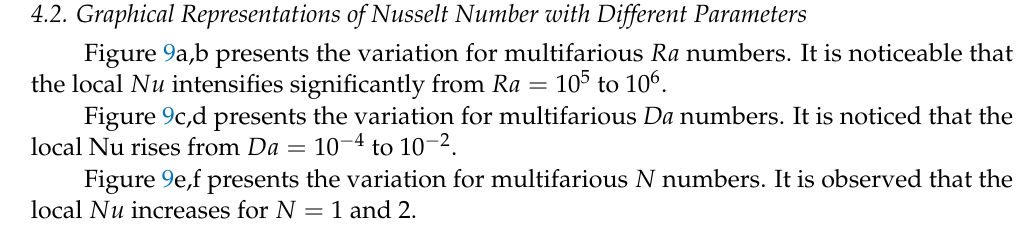
Figure 8. Isotherms for different values of power law indices n and undulations N .